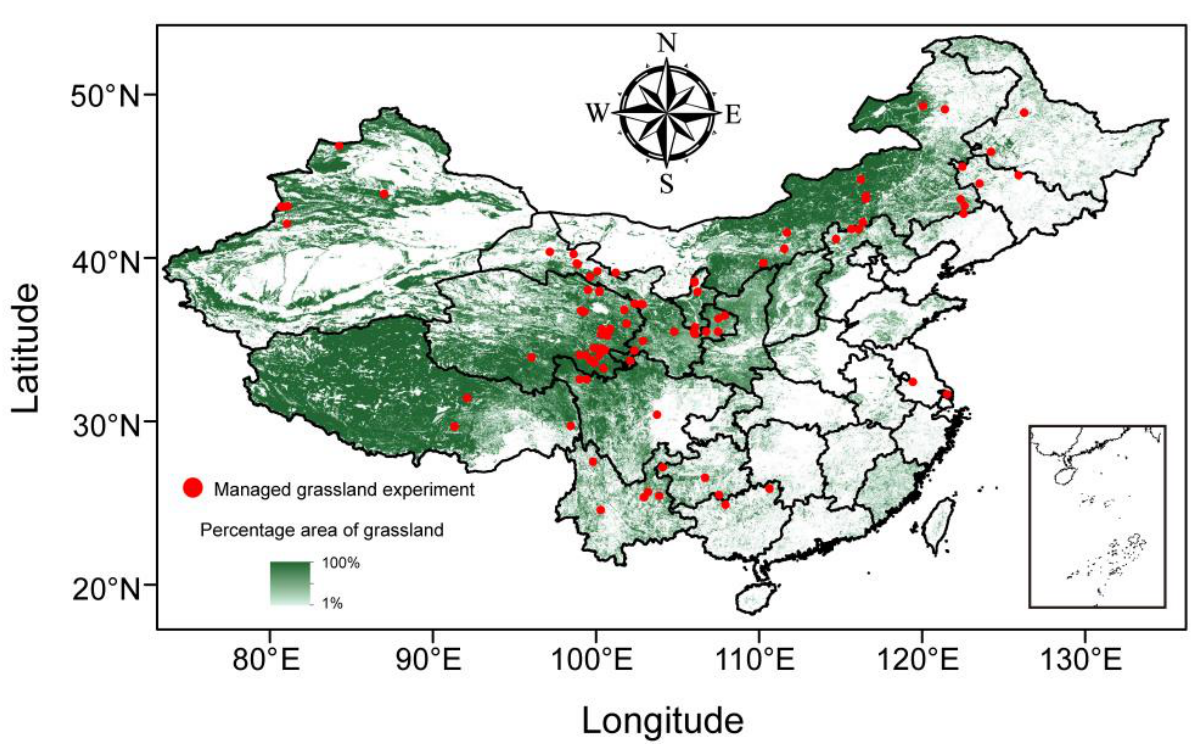
Figure 1. Locations of managed grassland experimental sites collected from literature reviews.